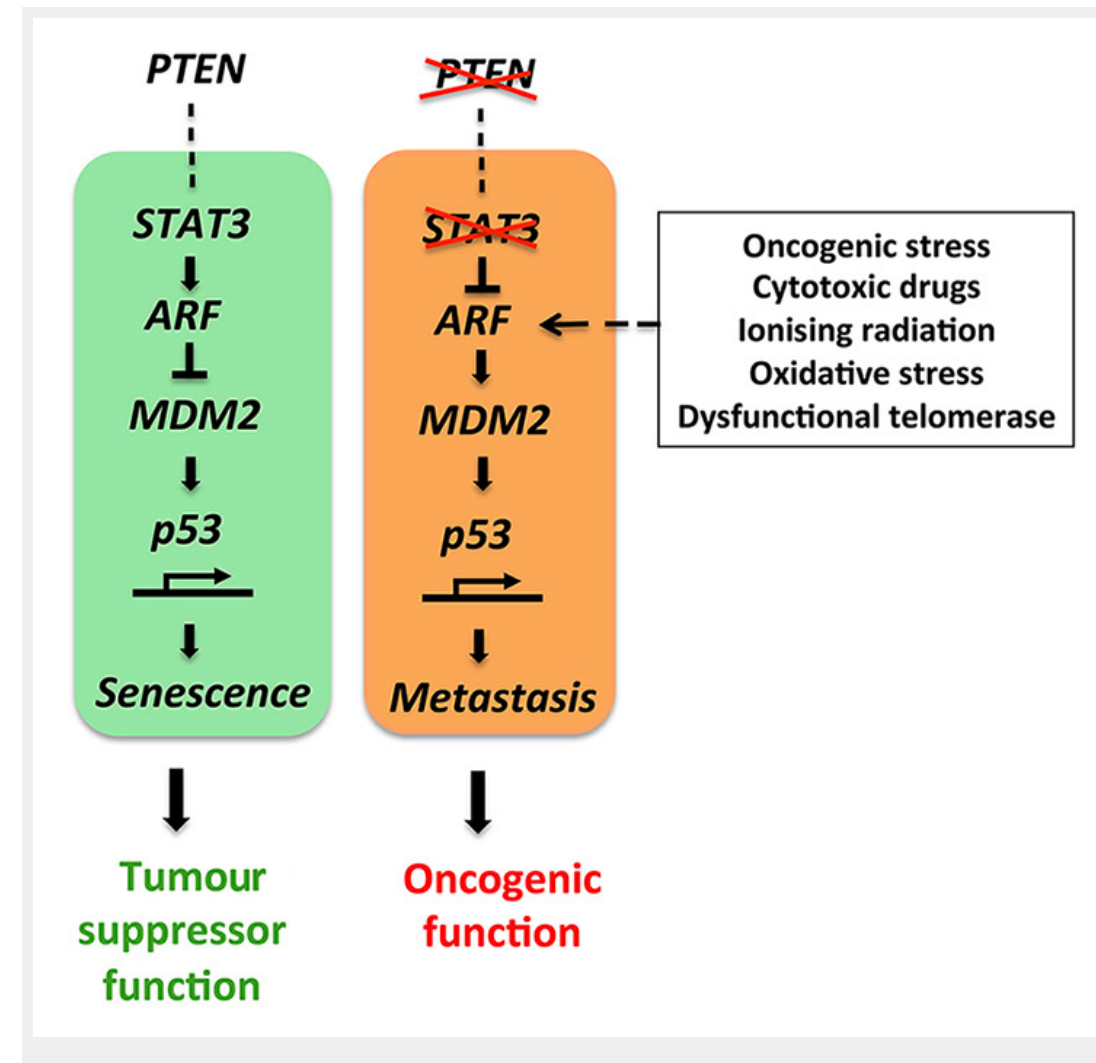
Figure 2 The STAT3-ARF tumour suppressor pathway is activated under normal conditions. Loss of PTEN and STAT3 function causes an oncogenic switch ultimately breaking the ARF-MDM2-p53 axis and inducing metastatic